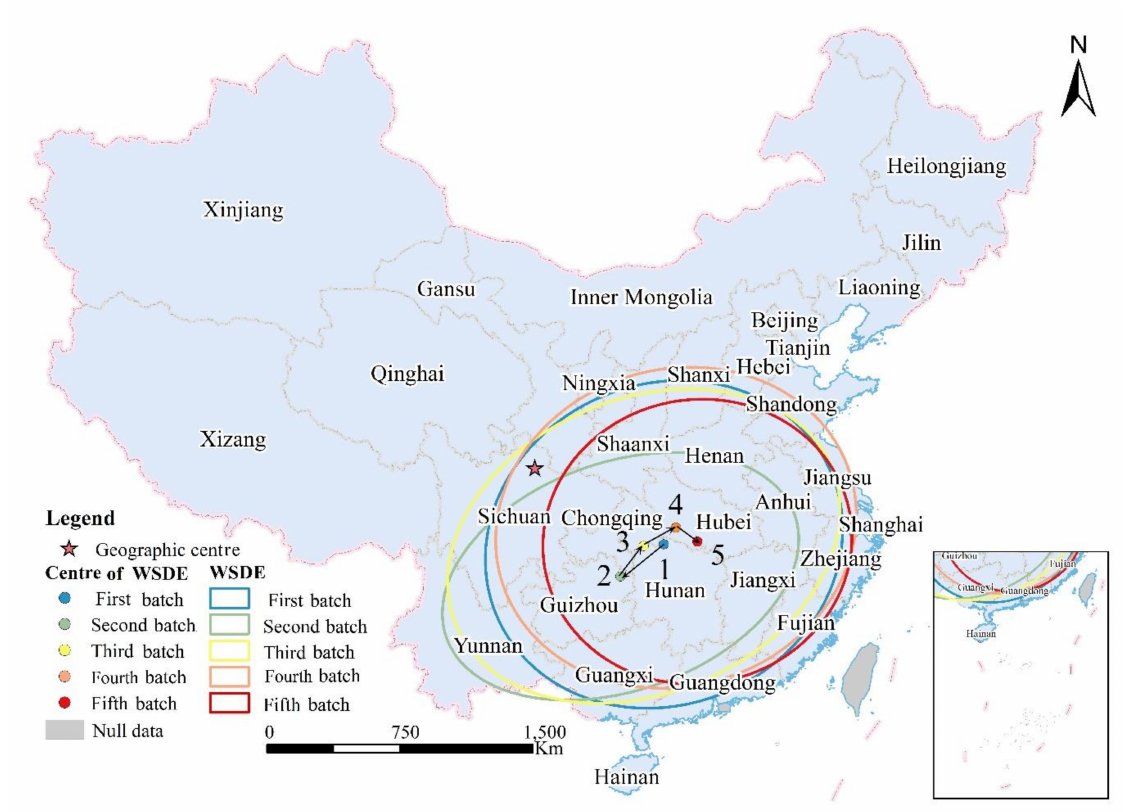
Figure 6. Weighted standard deviation ellipses (WSDEs) and trajectories of WSDE centers in